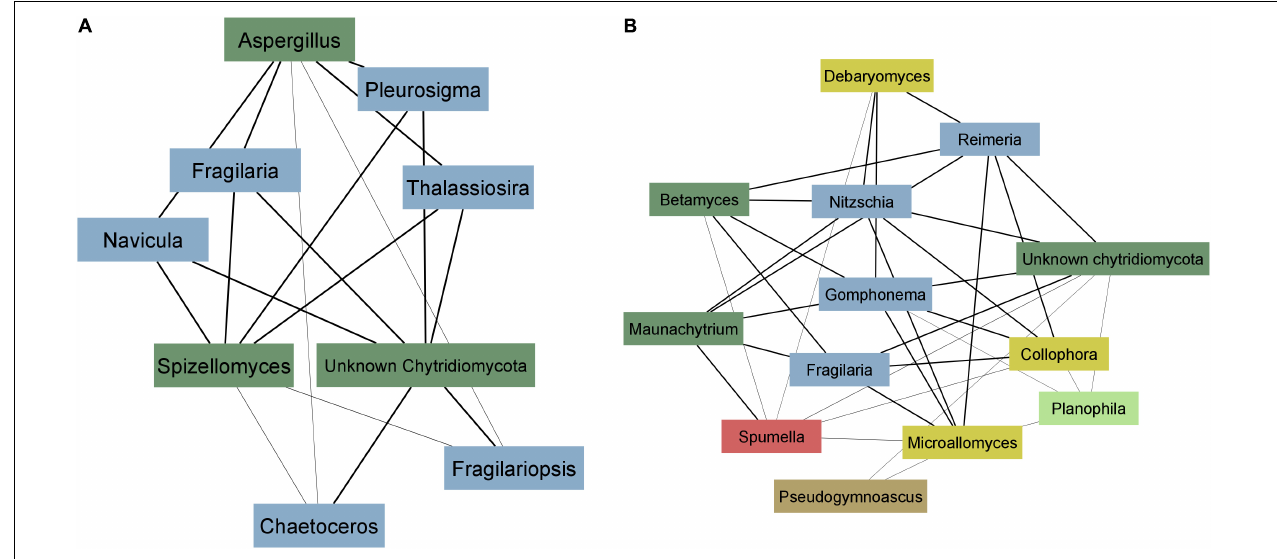
FIGURE 6 | Co-occurrence network analysis. (A) EukSSU3 and FunLSU5 modules (B) EukSSU4 and FunLSU2 module. Blue—Baccilariophyceae; dark green—Chytridiomycota; yellow—other Fungi; brown—Opisthokonta, red—Stramenopiles; light green—Chlorophyta.